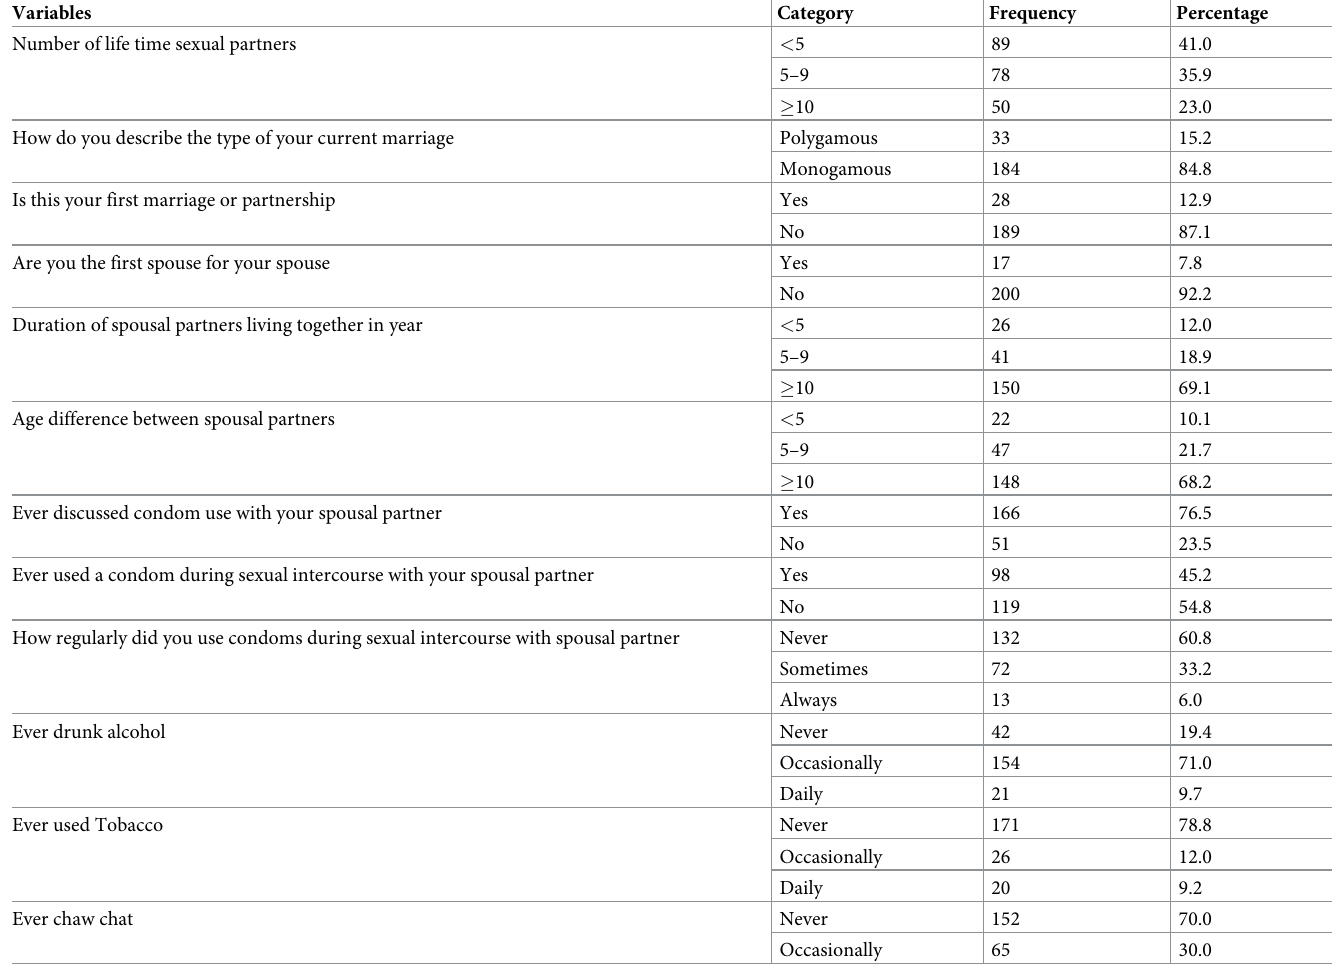
Table 2. Sexual and substance use behavior of spousal partners of index cases in Sodo Town, Southern Ethiopia, 2021 (N = 217). Variables